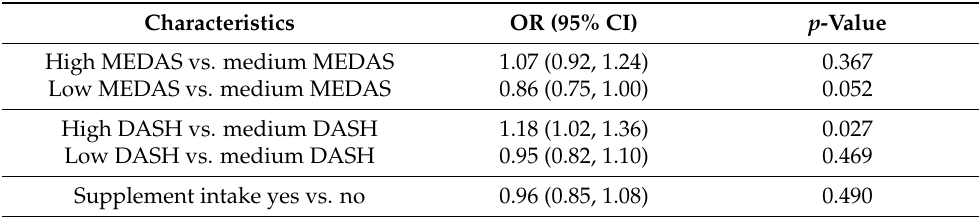
Table 3. Logistic regression models regarding the presence of carotid plaques.